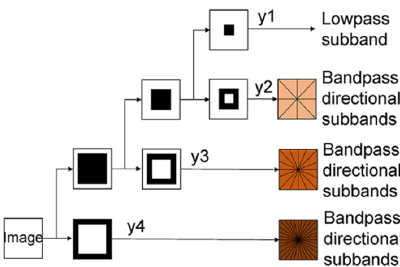
Figure 2. Image decomposition process of